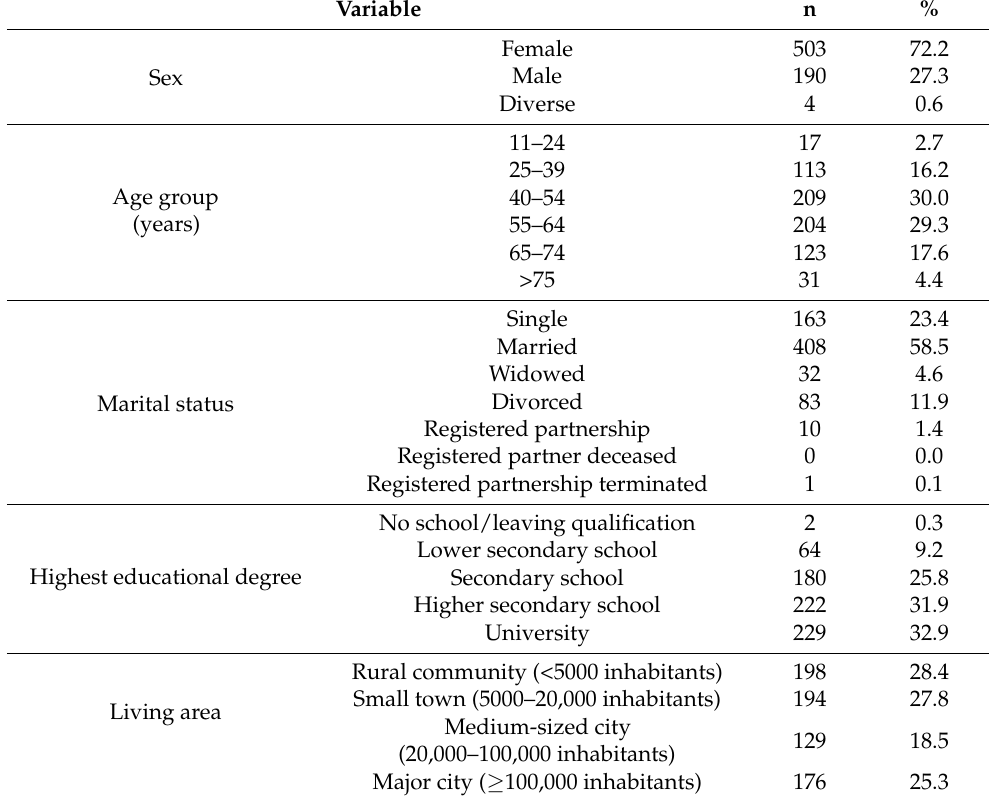
Table 1. Demographic data of the study population (N = 697; single choices). Variable